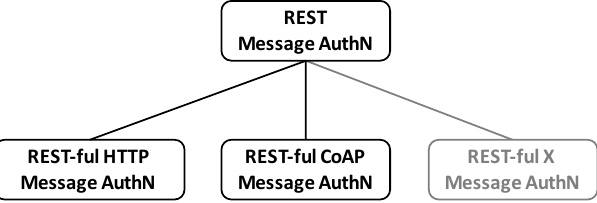
Figure 9. General REST message authentication and its instantiation to concrete REST-ful